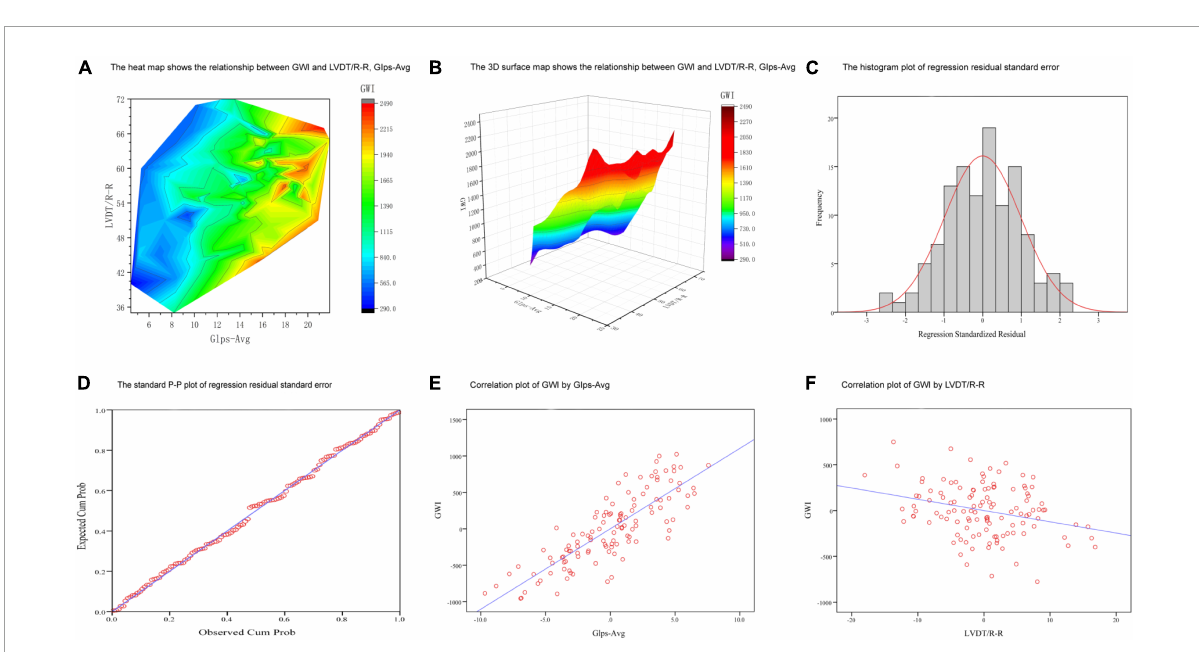
FIGURE4 Multiple linear regression analyses between GWI and key factors. (A,B) The 3D graphs show the relationship between GWI and LVDT/R-R, GIps-Avg. (C) The histogram plot of regression residual standard error. (D) The standard P-P plot of regression residual standard error. (E) Correlation plot of GWI by GIps-Avg. (F) Correlation plot of GWI by LVDT/R-R.